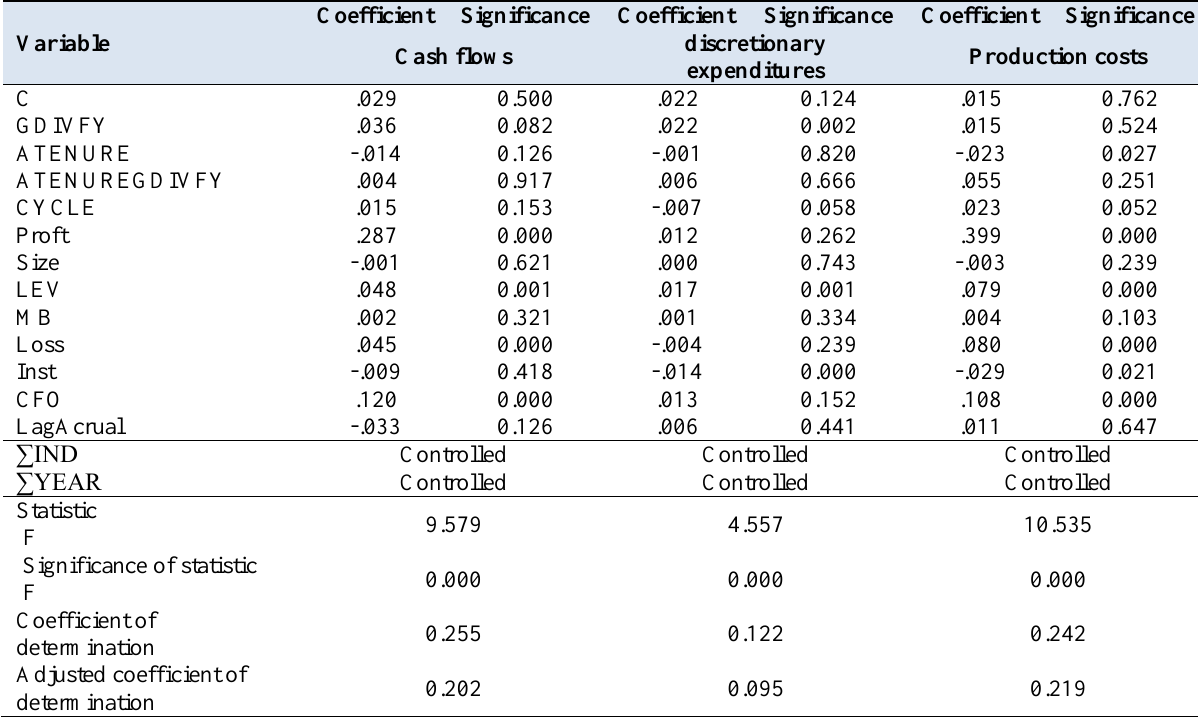
Table 6. The Results of Testing the Third Hypothesis (Dependent Variable: Real Earnings Management,